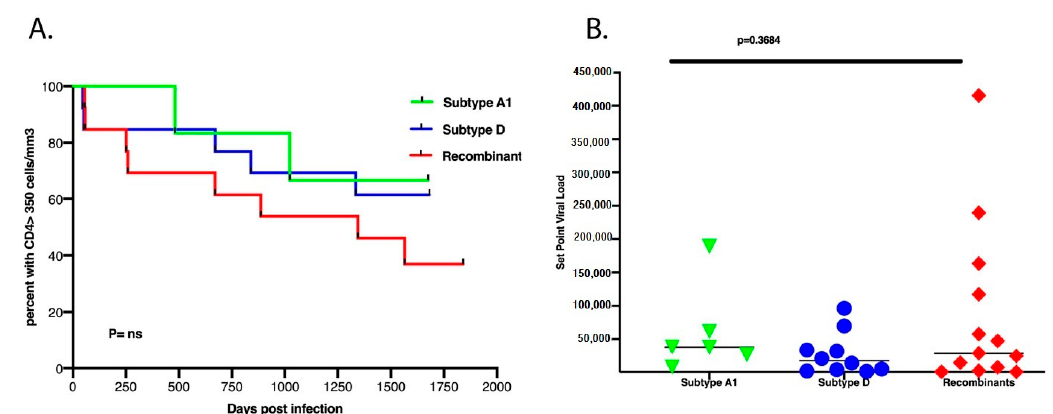
Figure 3. ( A ) There was no difference between the subtype classification of A1, D or the recombinants and the time taken for CD4 + T cell counts to decline to 350 cells/µL over the first 5.5 years of infection. ( B ) There was no difference between the subtypes and set point viral load.